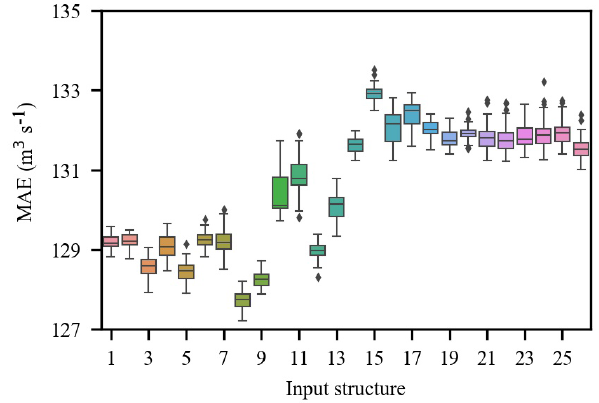
Figure A2. Trial results of 26 input structures from the reanalysis